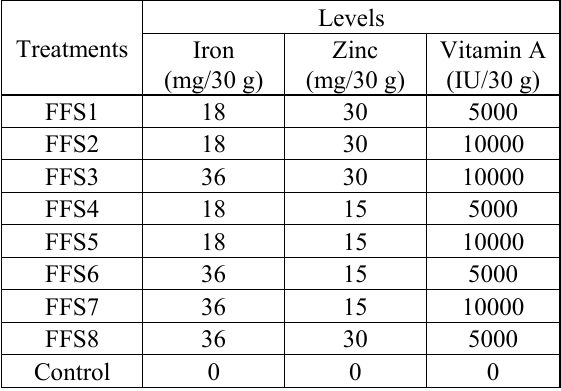
pH of fortified tamarind fish sauce is shown in Fig. 4a. There was a significant difference in pH between the control sample and the fortified samples (p < 0.05) with the control sample that had pH at 3.41 while the fortified ones had 3.18–3.33. [18] reported that the pH of the fortified pumpkin solution (containing 500 ppm of L–(+) ascorbic acid and 500 ppm Fe 2+ with the addition of 2.49 g/l FeSO 4 · 7H 2 O) was 3.60, while the control